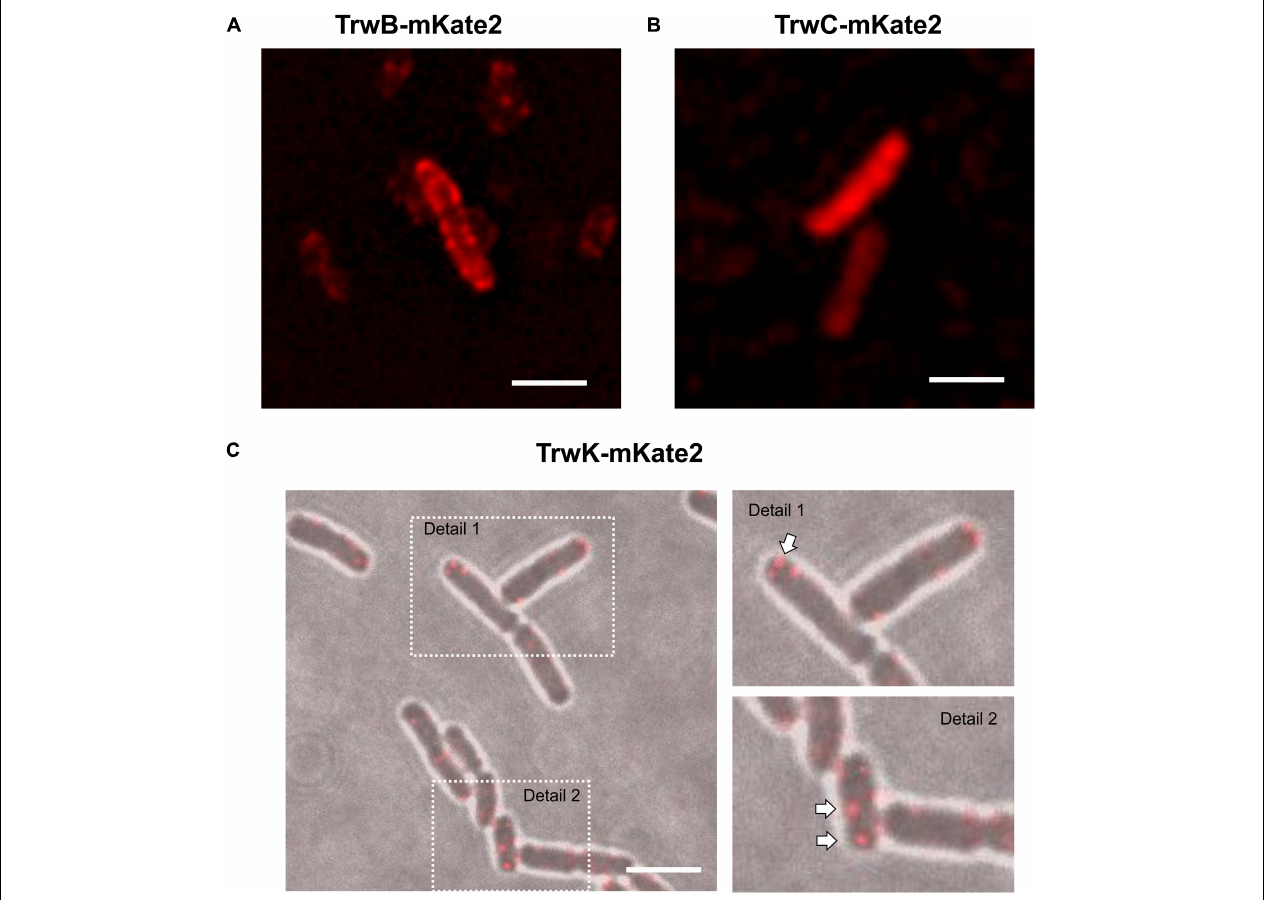
FIGURE 2 | Localization of conjugative proteins in donor cells in the absence of recipients. MG1655 cells expressing TrwBmKate2 (A) , TrwCmKate2 (B) , and TrwKmKate2 (C) were grown in M9 minimal media and examined by fluorescent microscopy. In all cases, fusion proteins are expressed under its respective natural promoter in plasmid R388. TrwBmKate2 was widely distributed in the membrane (A) (see also Supplementary Movie 1 ), TrwCmKate2 was dispersed in the cytoplasm (B) and TrwKmKate2 was found forming discrete foci (around six per cell) (C) , which might indicate the number of secretion systems assembled. In this last case, phase contrast/color bright field images are shown to better visualize both the foci, and the bacterial cells. (Scale bar: 2 µ